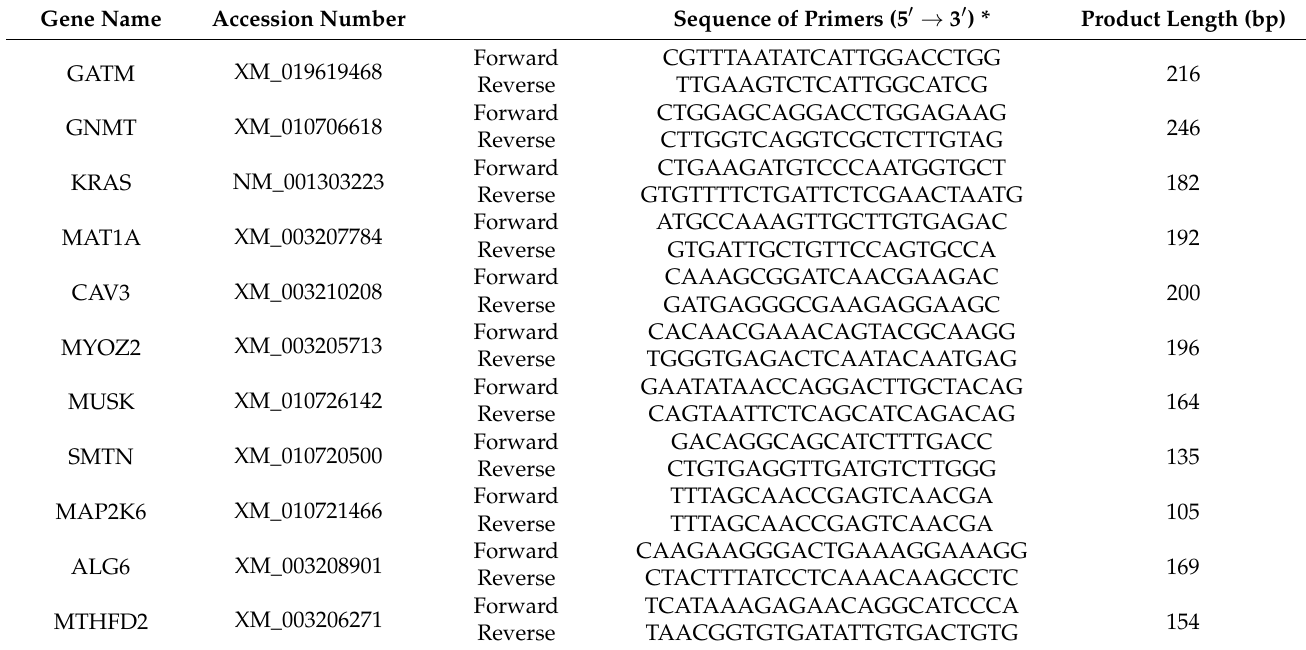
Table 1. The primer sequences of target genes and housekeeping genes used in this